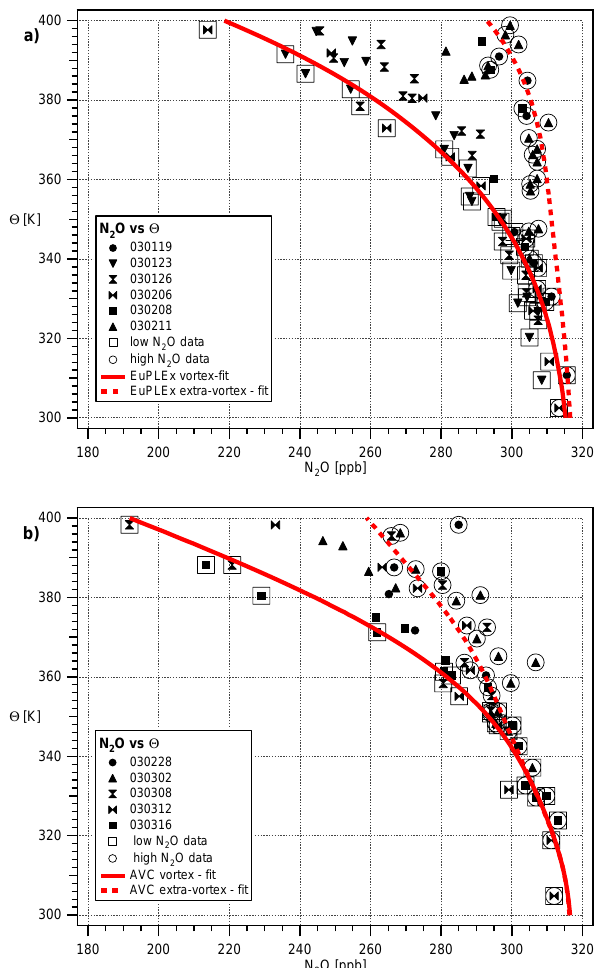
Fig. 7. N 2 O (ppt) plotted versus the potential temperature θ (K) in the LMS for EuPLEx (a) and AVC (b) . The “low N 2 O data” are highlighted by black squares and the “high N 2 O data” are high- lighted by black circles. The corresponding Vortex (line) and Extra- Vortex fit (dashed line) are plotted in